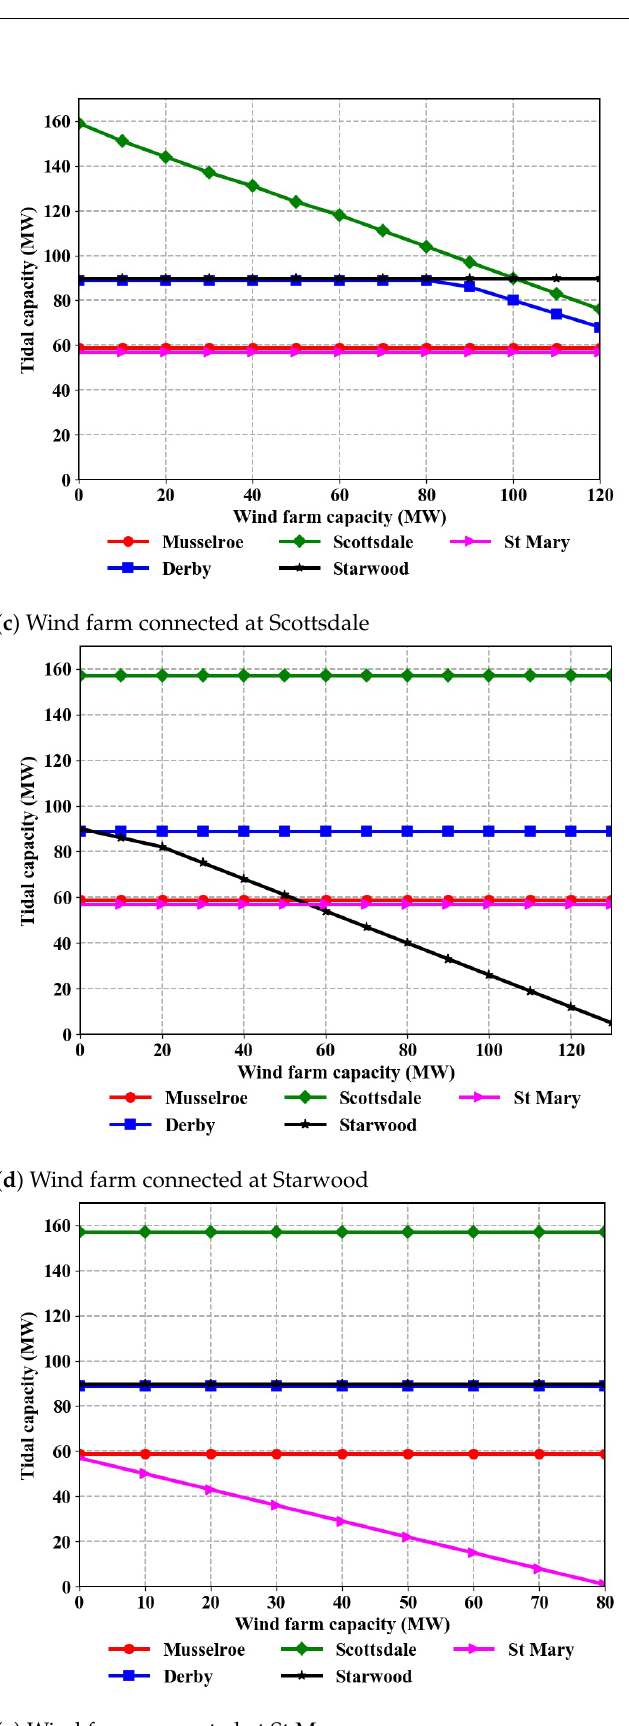
Figure 6. Impact of a potential wind farm on locational tidal HC in the Tasmanian